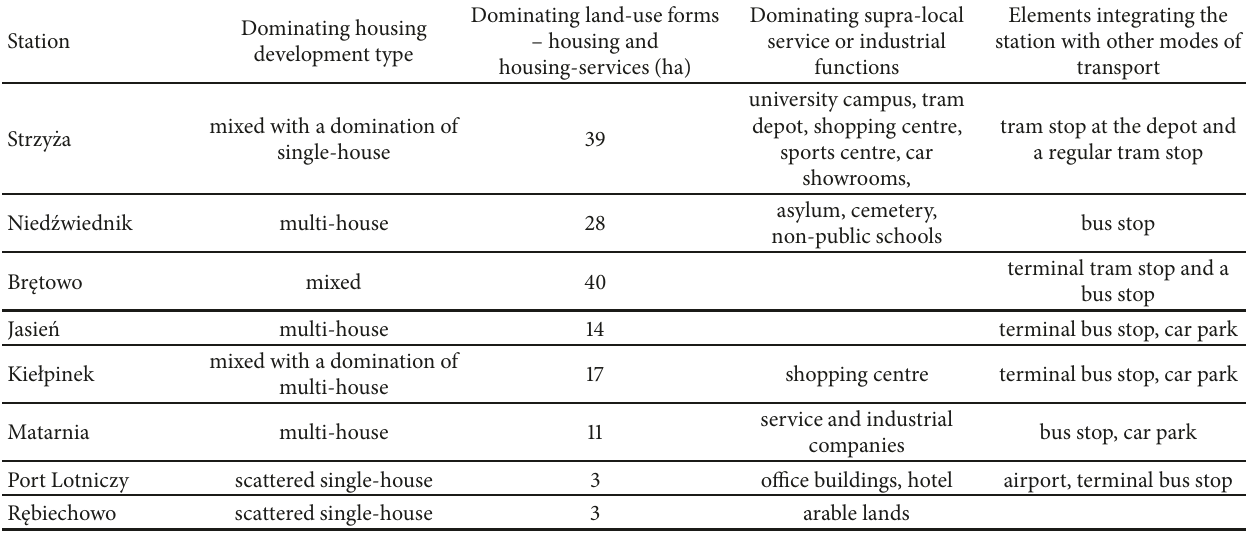
Table 1: Land use forms in the closest vicinity of (660 m radius) the PMR stations in Gda´nsk (at the end of July